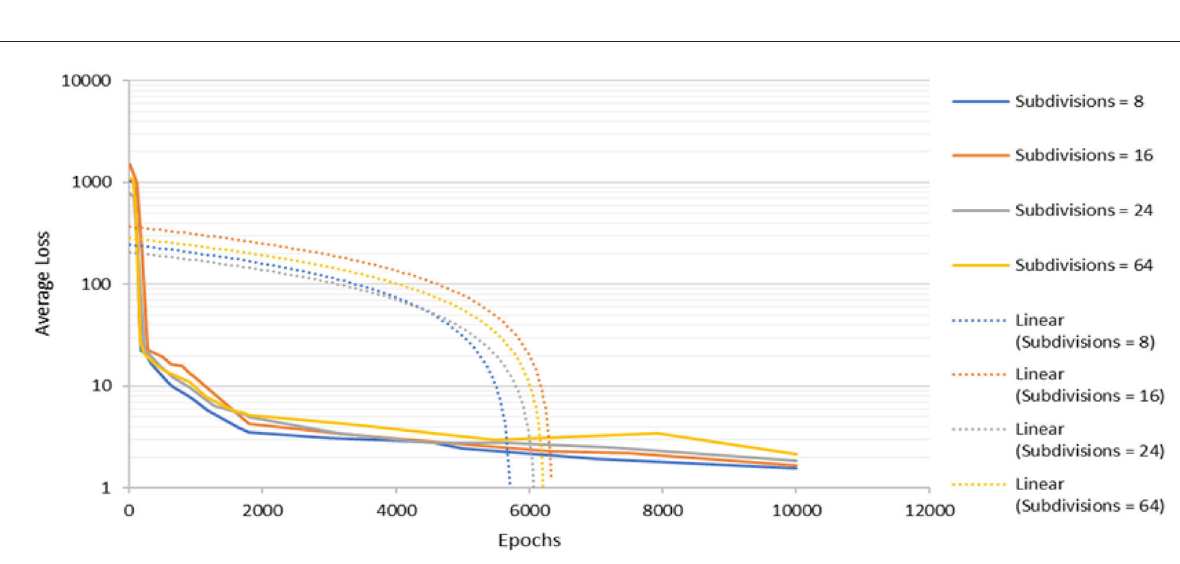
FIGURE5 The detection model’s convergence rate for various subdivisions